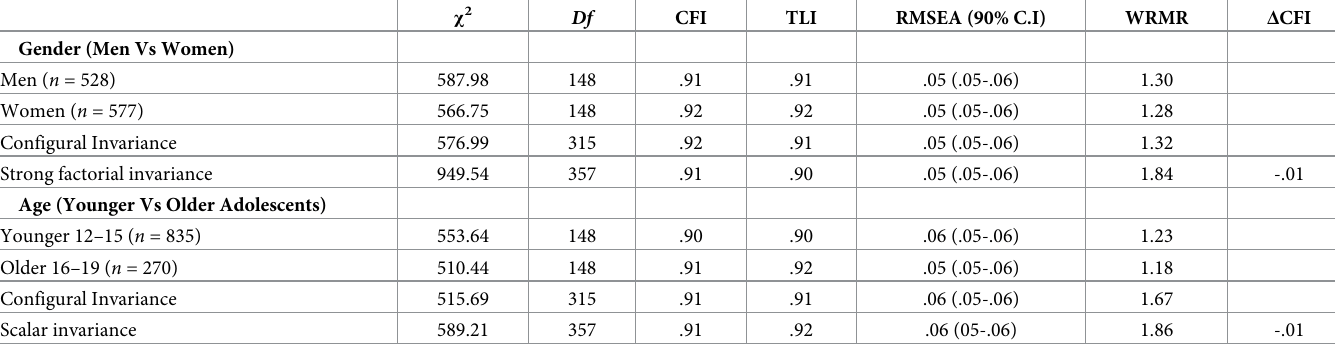
Strong factorial